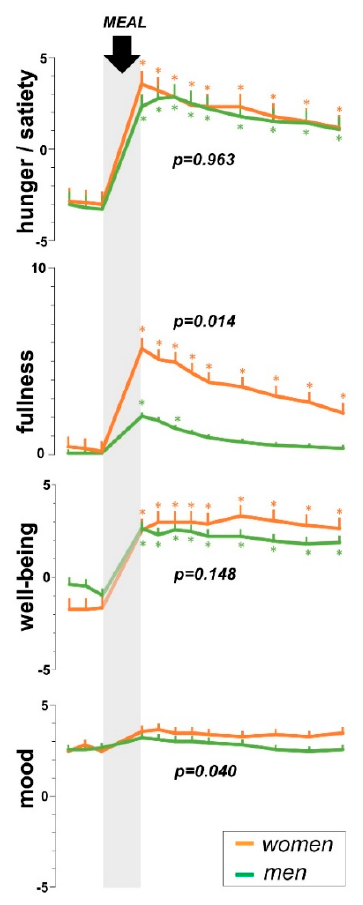
Figure 1. Postprandial experience in women and men. Main gender-effect by repeated measures ANCOVA shown; dependent variable: postprandial scores; covariate: pre-meal scores. Temporal responses to meal ingestion analyzed by one-way ANOVA for repeated measures; asterisks indicate significant differences from premeal values by post-hoc comparisons ( p < 0.05 applying the Sidak correction procedure for multiple comparisons). Postprandial sensations tended to be higher in women than in men, but the differences in satiety and digestive well-being were blurred because the scores were near the top of the scales in both groups.